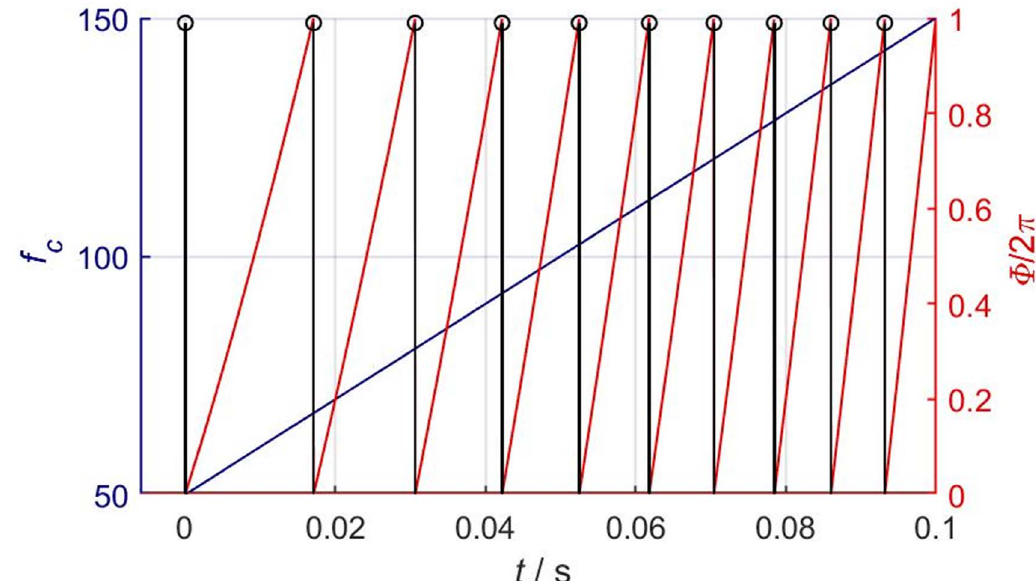
Figure 1. Principle of strobe-point generation: The fundamental frequency estimate of a periodic signal is assumed to increase linearly from 50 Hz to 150 Hz in the time interval 0 – 100 ms (blue curve, left scale). The corresponding phase function according to (2) is normalized by 2 p and taken modulo 1 (red curve, right scale). Whenever the phase wraps, a strobe point is set (indicated by black bars with circles on top). The time span between subsequent strobe points indicates the stabilized